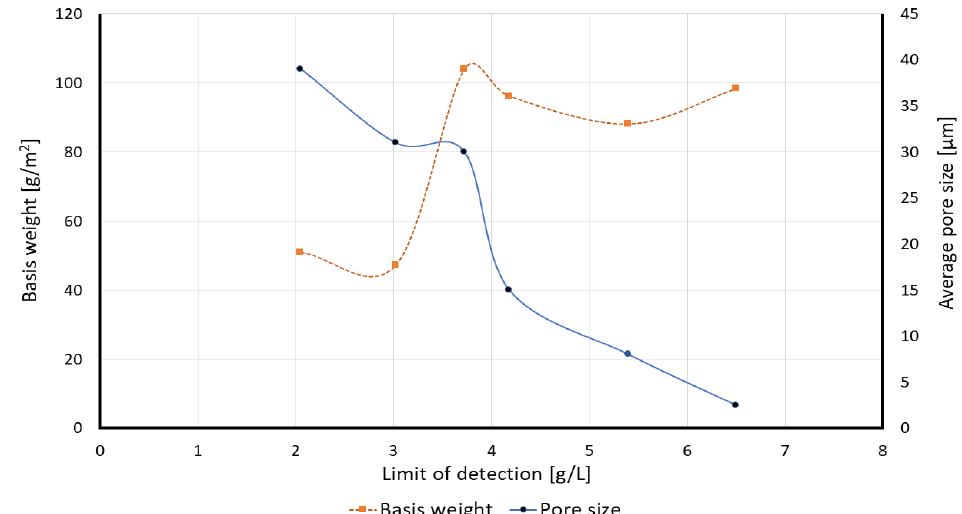
Figure 14. Comparison between the effect of the basis weight and the average pore size on the